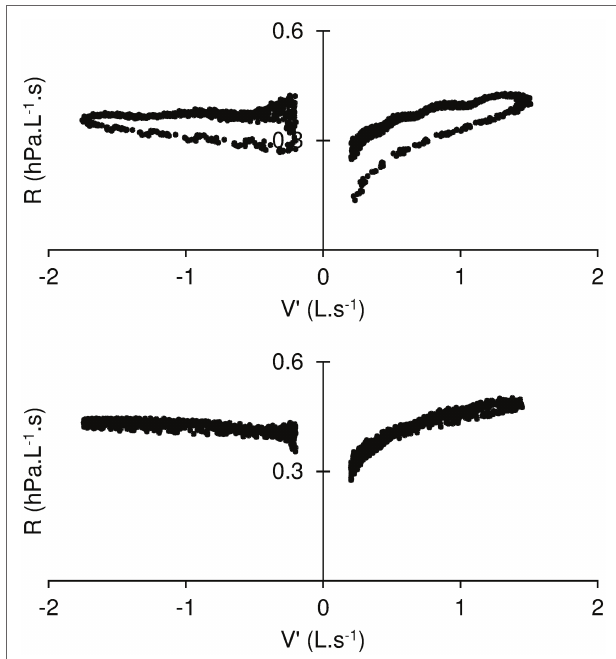
FIGURE 4 | Resistance (R) – Flow (V ′ ) diagram during standard measuring conditions (top) and while the mask motion is prevented by manually holding its edges. The manoeuver is associated with disappearance of the looping of R vs. V ′